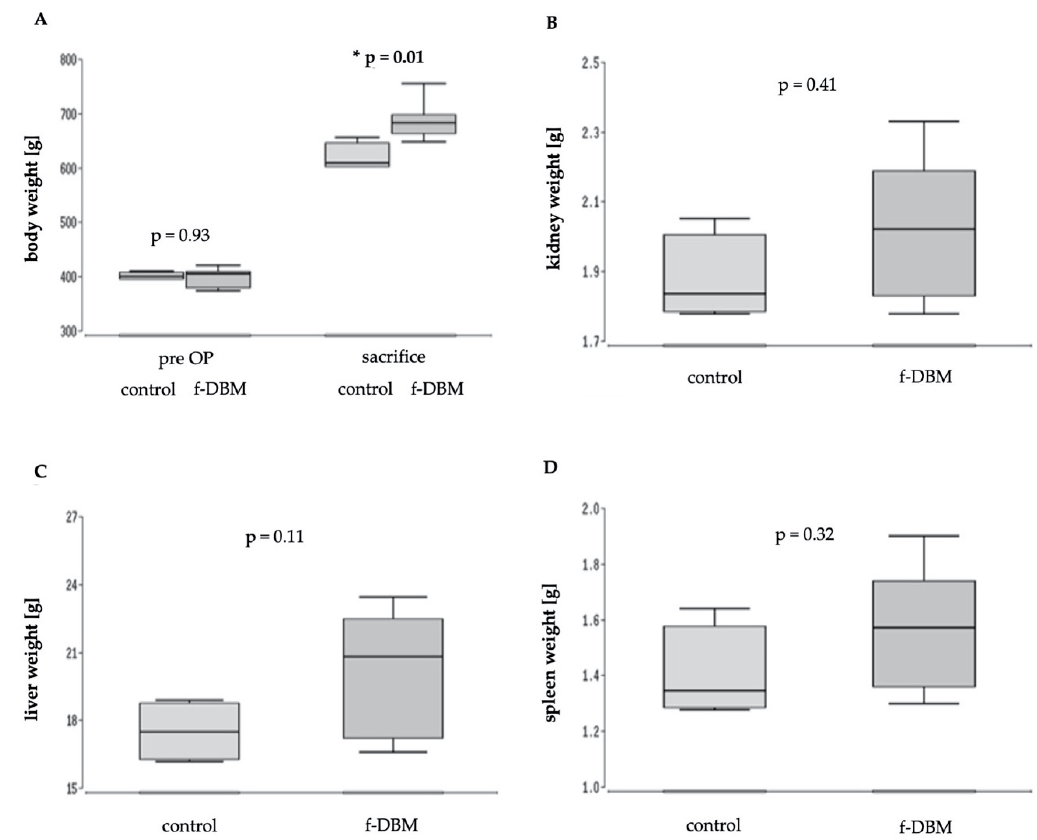
Figure 2. Weight gain in the two groups over the follow-up period. ( A ) Significant weight increase in both groups. Weight gain of selected organs at the time of sacrifice: ( B ) liver, ( C ) kidney, ( D ) spleen.